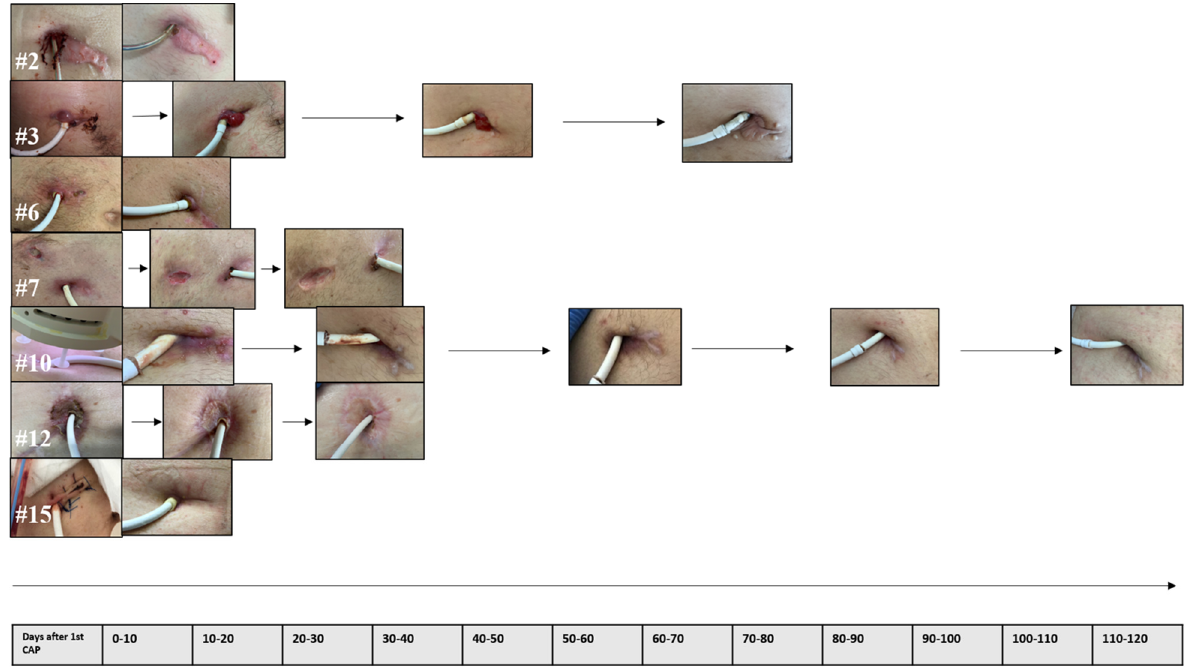
Figure 1. Wound history in seven patients with complete wound healing after CAP treatment